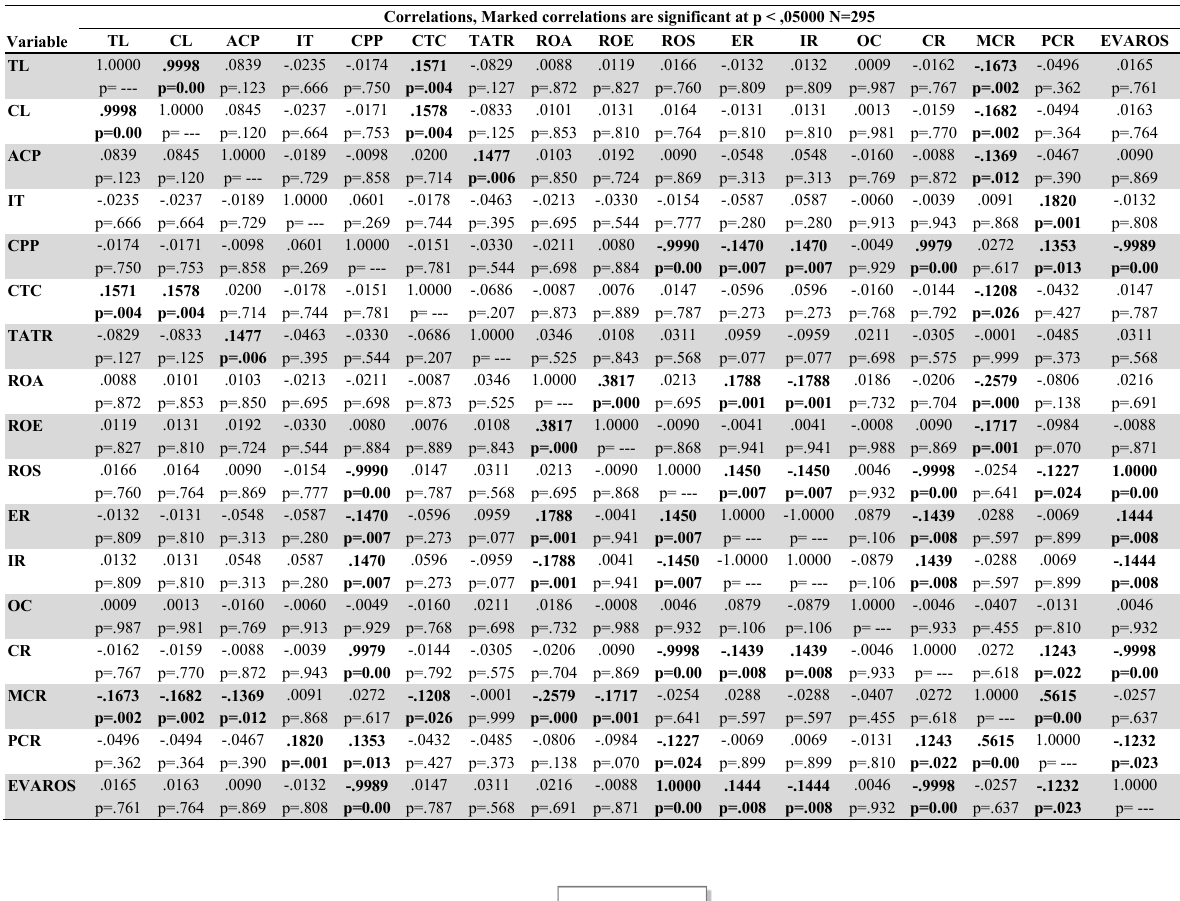
Correlation matrix